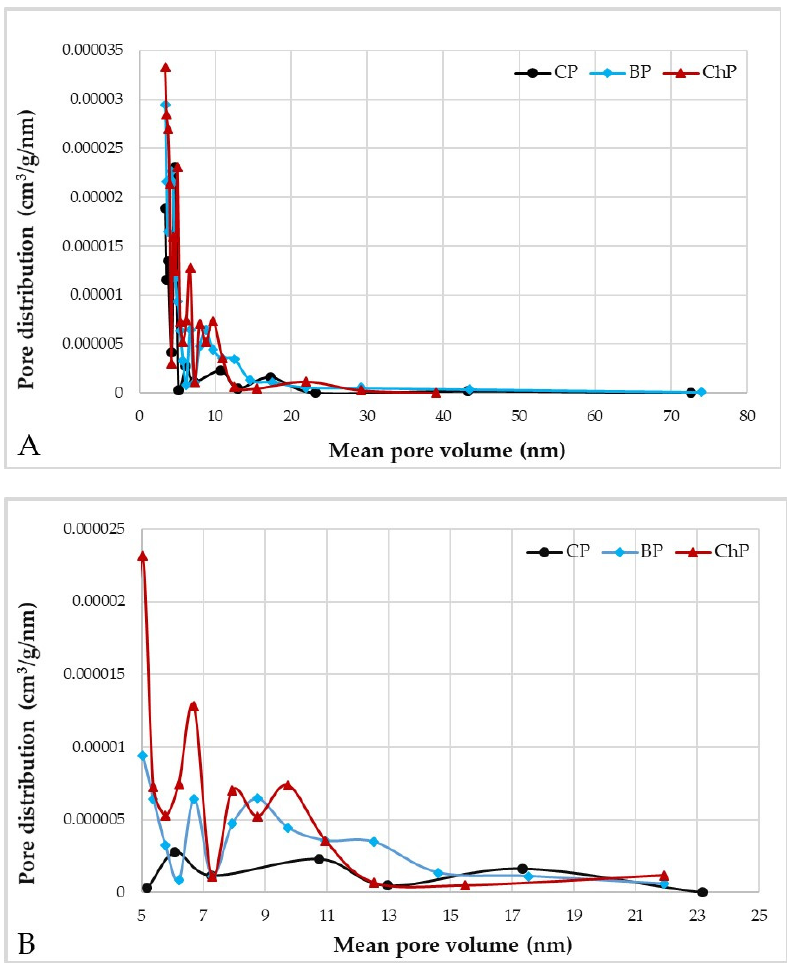
Figure 6. Pore distribution as a function of the pore volume illustrating the different distribution types for undegraded and artificially degraded pine wood ( A ) and a micro- and mesopore region showing more details of pore distribution ( B ); CP—contemporary sound pine, BP—biologically degraded pine, ChP—chemically degraded pine.